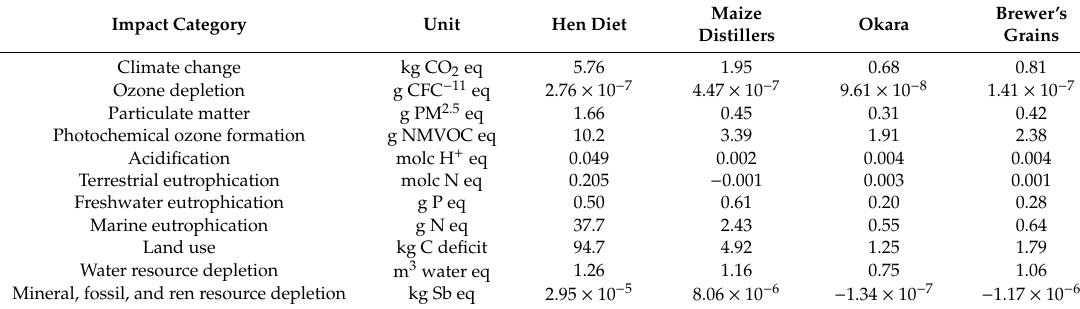
Table 6. Environmental impact of larvae grown on di ff erent substrates (kg of larvae dry weight).